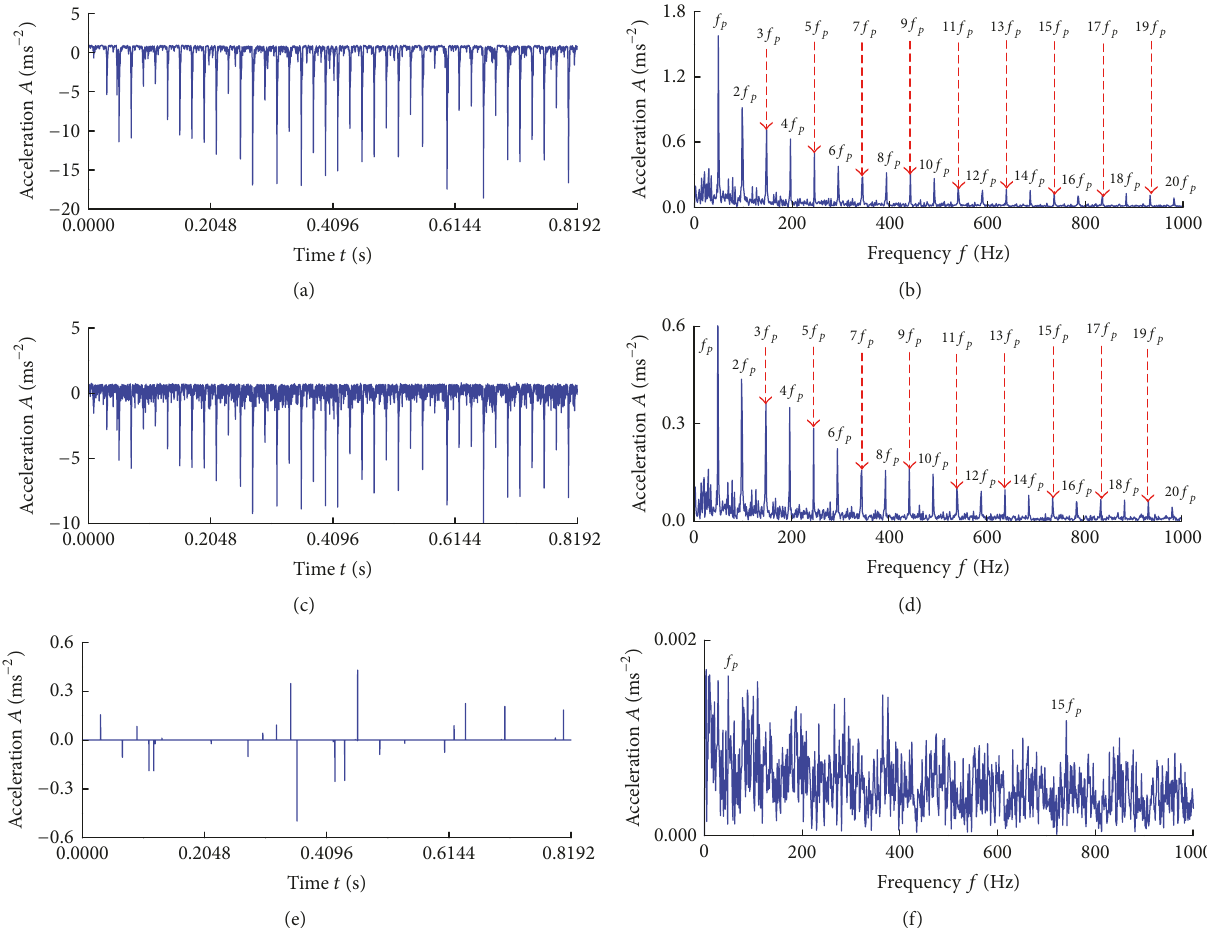
Figure 3: The intrinsic impulse-envelopes extracted by the impulse-envelope manifold and their envelope spectra: (a) impulse-envelope with Isomap and (b) the envelope spectra of (a), (c) impulse-envelope with LLC and (d) the envelope spectra of (c), (e) impulse-envelope with LTSA, and (f) the envelope spectra of